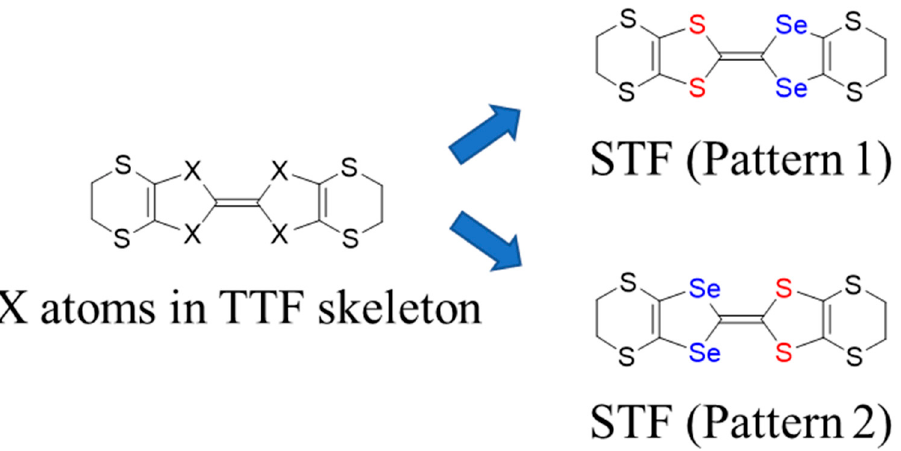
Figure 2. Two possible packing patterns of the STF molecule at a given site in α -STF 2 I 3 (X = S or Se).